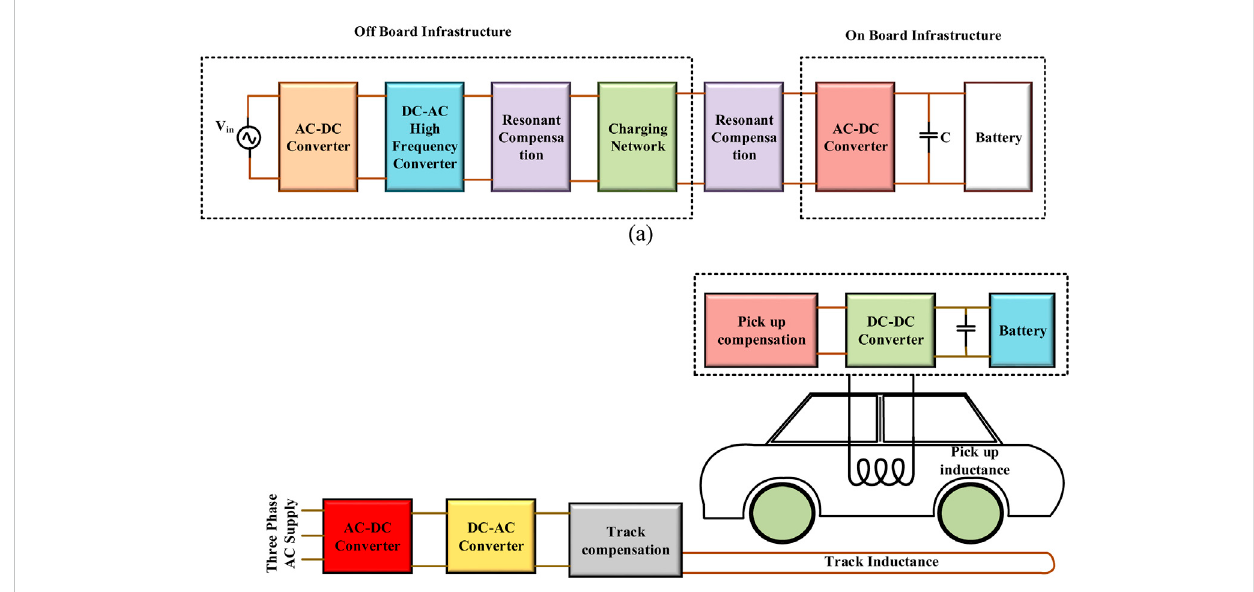
FIGURE 9 Electric car static and roadbed inductive charging.